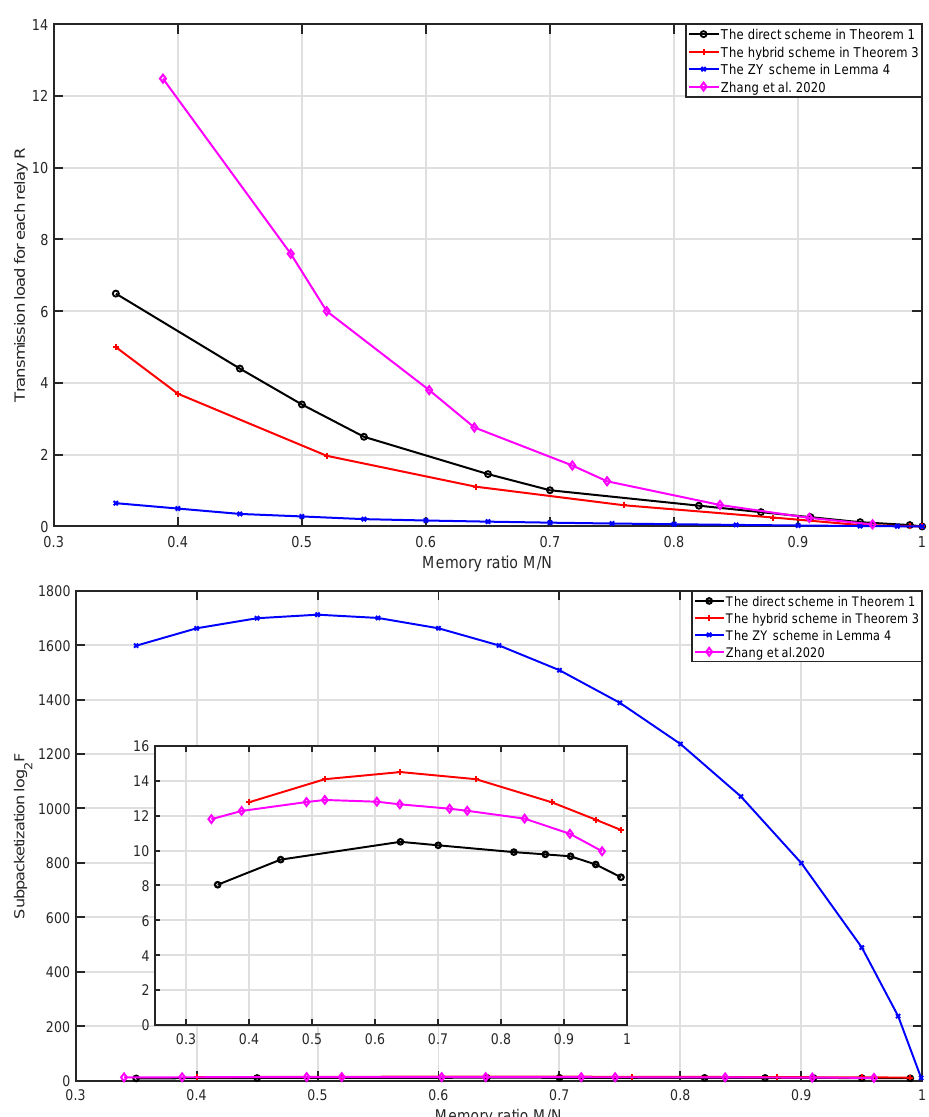
Figure 2. Comparison of the direct scheme and the hybrid scheme with the ZY scheme and the naive scheme when H = 14, r = 4, u =